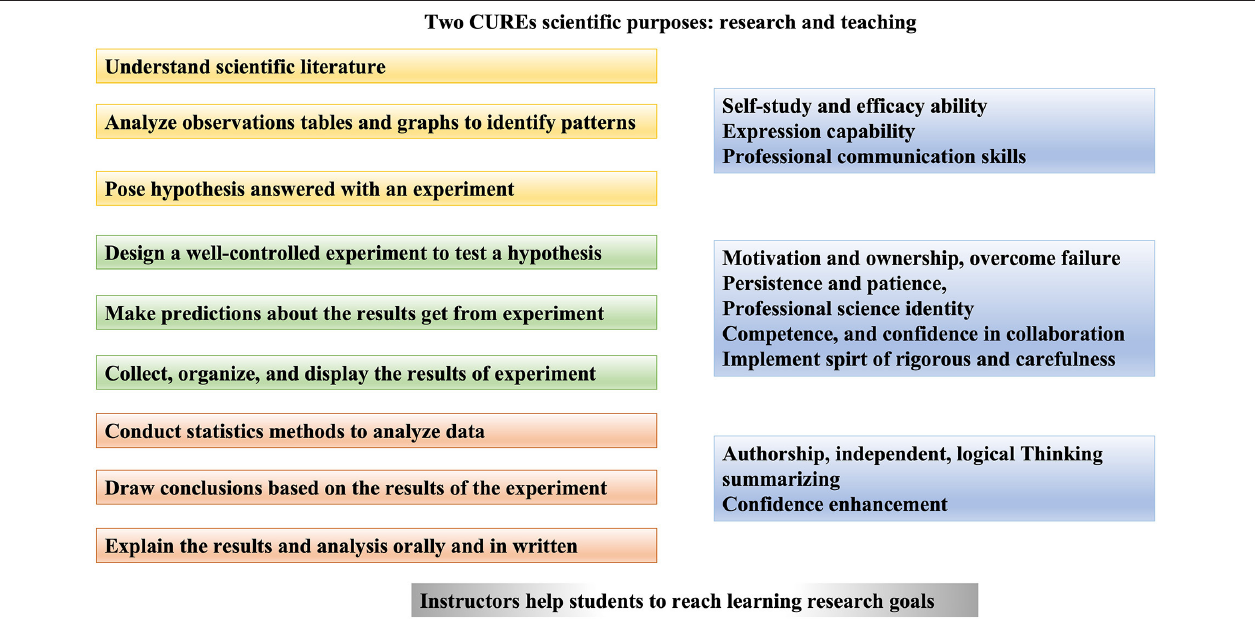
FIGURE 3 | Steps of flow chart for 16S rRNA gene amplicon